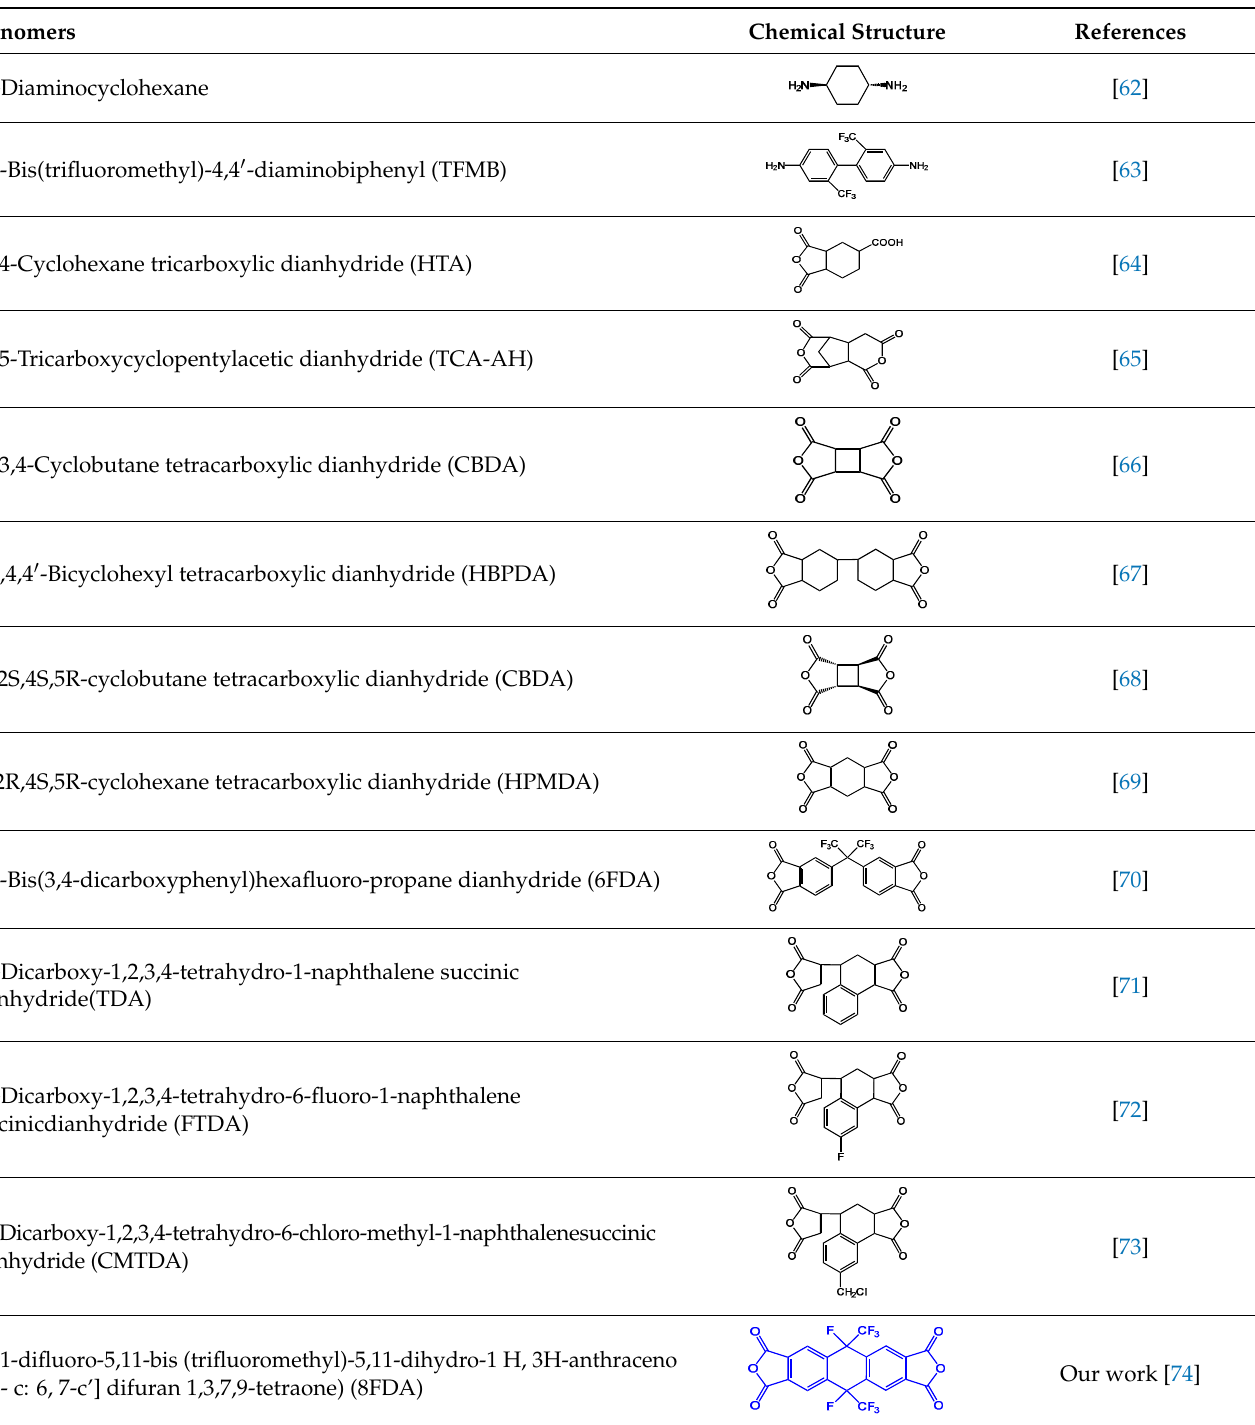
Figure 4. Schematic of CPI molecular design principles. Reprinted with permission from Ref. [61]. 2015, Elsevier. Table 2. Typical monomers for CPI synthesis.